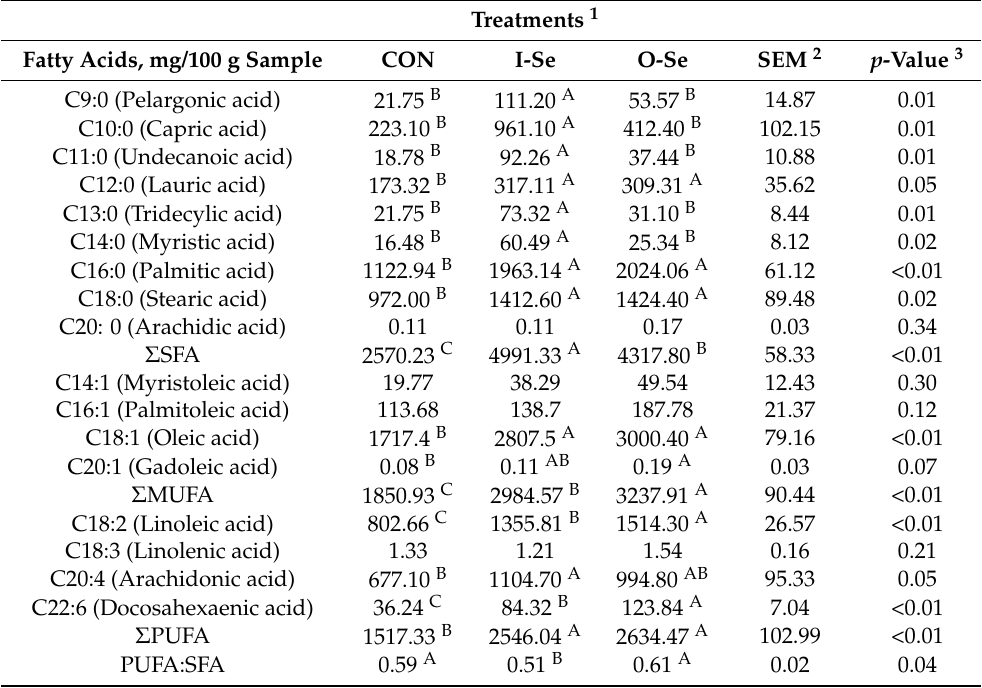
Table 4. Effects of dietary supplementation with inorganic or organic selenium on the fatty acid profile for goose meat (equal portions of the breast and thigh meat) of native Azerbaijan